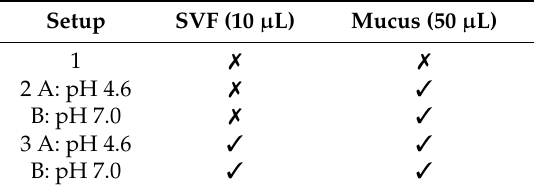
Table 2. Setups used for the permeation studies.